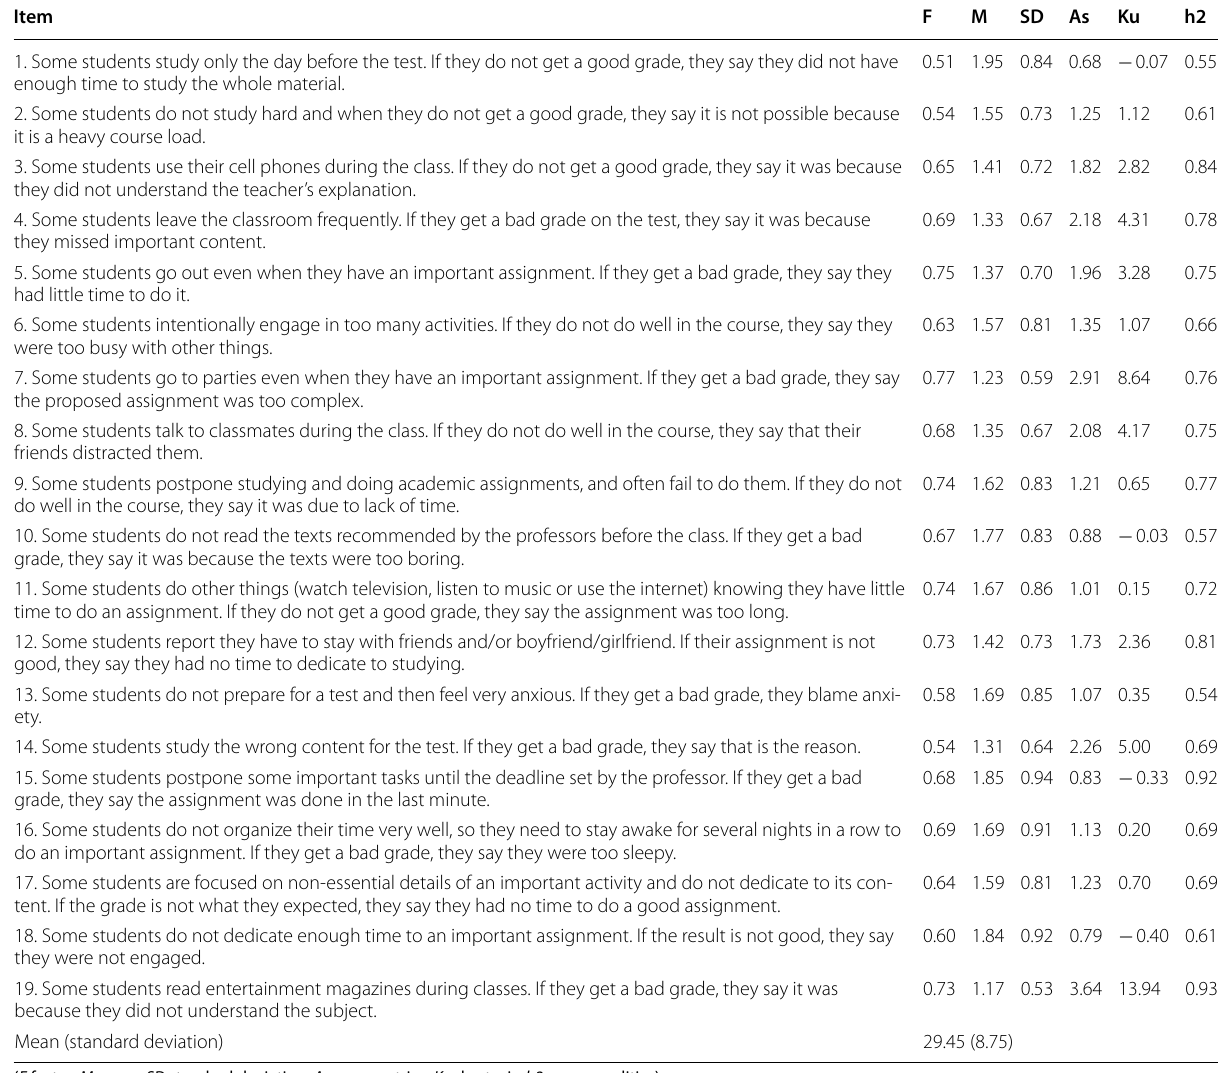
( F factor, M mean, SD standard deviation, As asymmetries, Kur kurtosis, h2